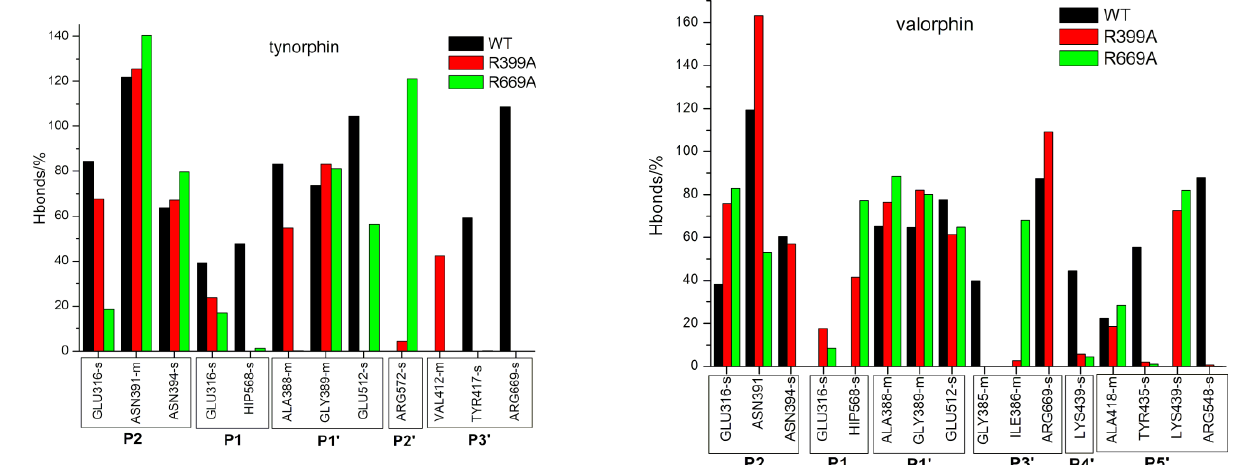
Figure 3. Hydrogen bond occupancy (shown only when occupancy > 20% in at least one complex) calculated by using the Hbonds plugin (VMD) between the ligand and the rest of the protein. Angle and distance cut-offs were 45° and 3 Å , respectively. Indicated amino acids participated as hydrogen bond donor and/or acceptors (for more details see Figure S3). When applicable, it is also indicated whether only the atoms of the side chain (s) or of the main chain (m) were involved in hydrogen bonding.